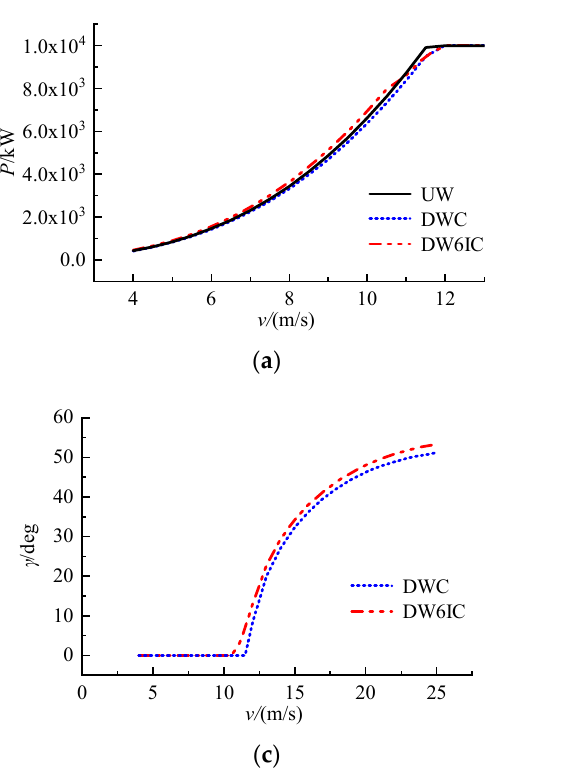
Figure 6. ( a ) Output power curves. ( b ) Rotor swept area curves. ( c ) Rotor cones angle curves. ( d ) Loads of blade root curves.